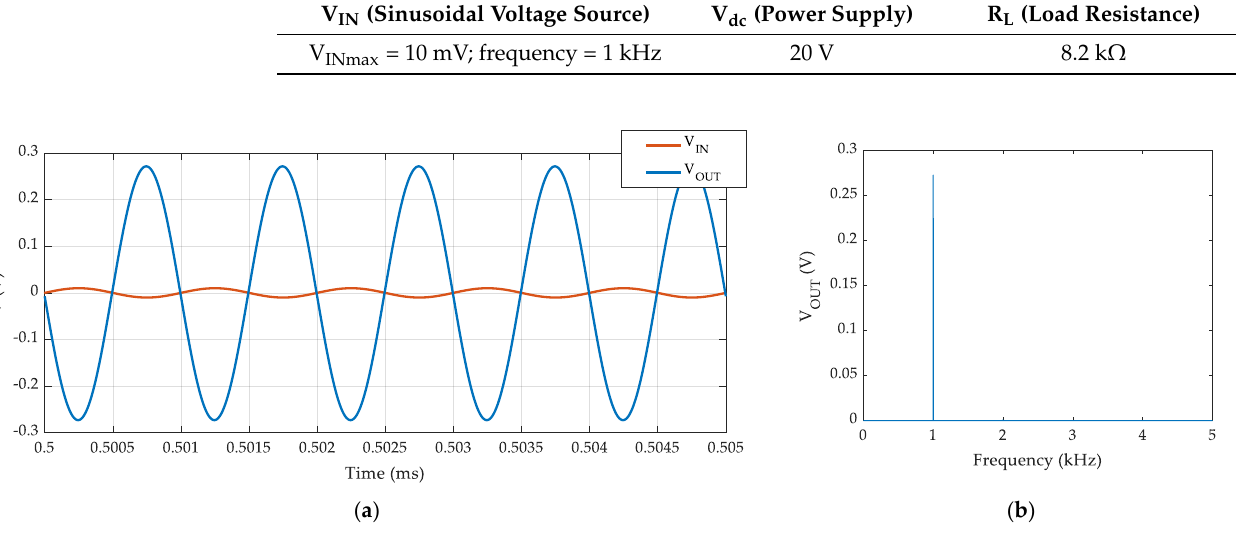
Figure 2. ( a ) Input and output voltages; ( b ) FFT of the output signal. Table 1. Nominal values and tolerances of the passive components of the circuit.